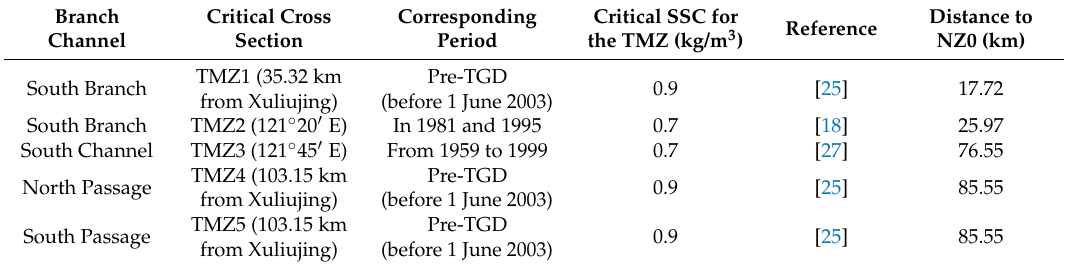
Table 1. SSC objectives for the upper limits of the five TMZs in the Yangtze River Estuary.